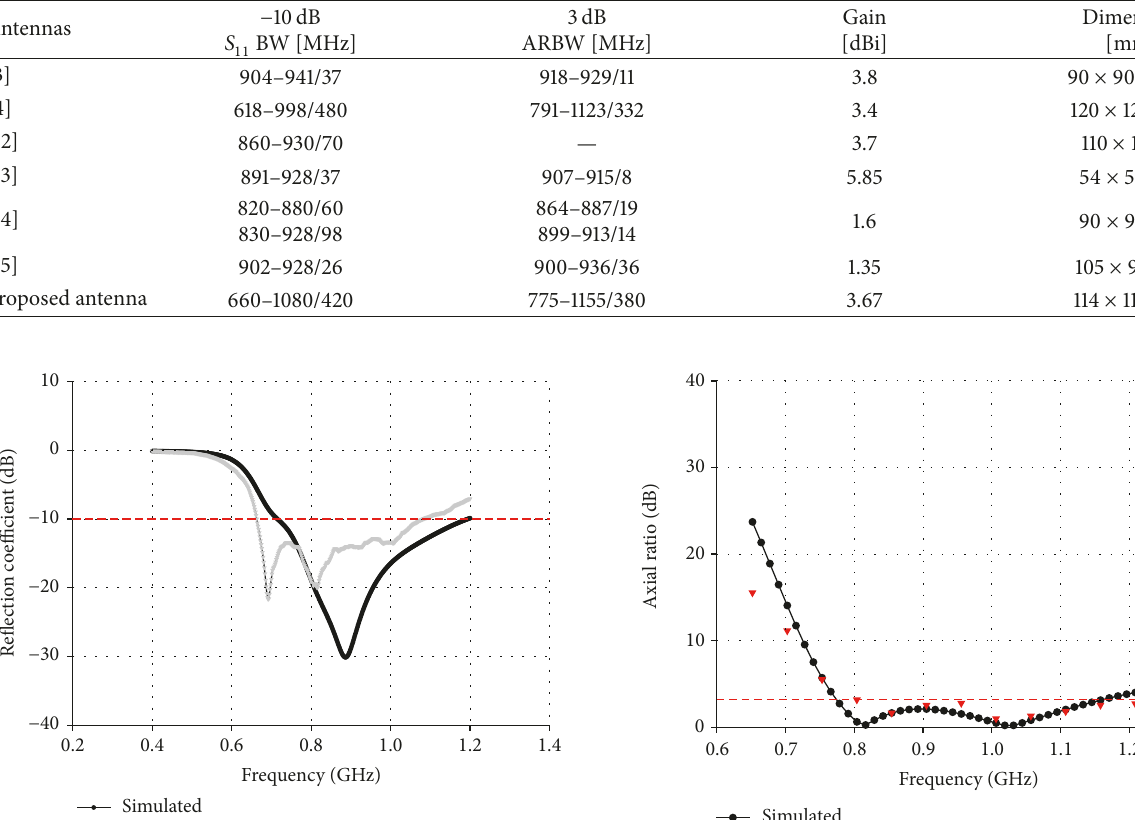
Figure 5: Three dB axial ratios of the proposed antenna with various L 1 , 𝐿 1 Table 3: Comparison of the proposed antenna and different antenna.